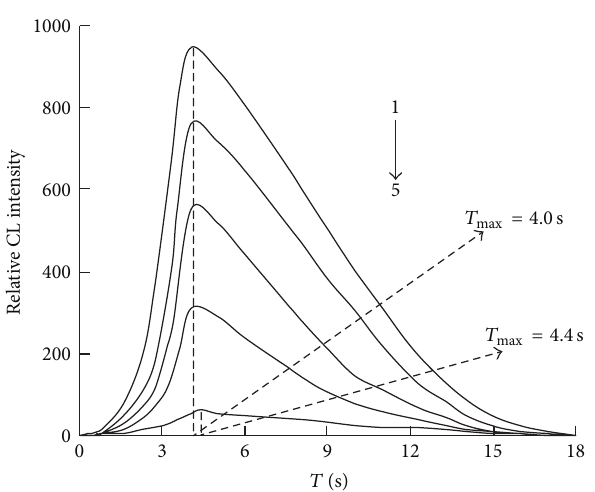
Figure 4: The relative CL intensity-time profile. Curve 1: luminol- Co 2+ system; Curve 2–4: luminol-Co 2+ -UA system; Curve 5: luminol-dissolved oxygen system; Luminol: 5.0 × 10 −6 molL −1 ; Co 2+ : 1.0 × 10 −8 molL −1 ; UA: 5.0, 30.0 and 300.0 nmol L −1 for Curves 2, 3, and 4, respectively.